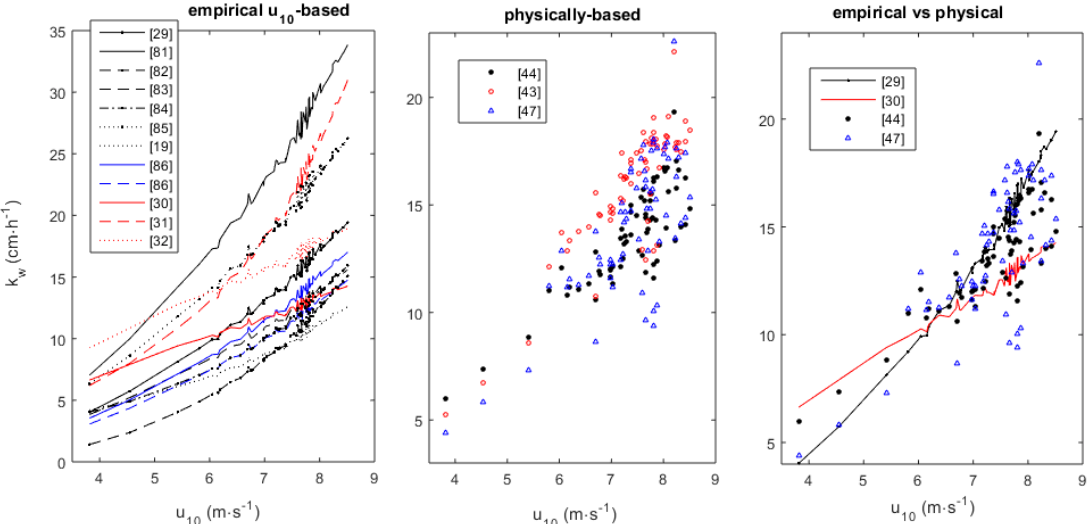
Figure 5. Comparison among transfer velocities (k w ) estimated for the Baltic experiment from empirical u 10 -based parameterizations and from extended physically based formulations. Were tested the empirical u 10 -based parameterizations by Wanninkhof et al. [19], Wanninkhof [29], Carini et al. [30], Raymond and Cole [31], Borges et al. [32], Jacobs et al. [81], Wanninkhof and McGillis [82], Nightingale et al. [83], McGillis et al. [84], Weiss et al. [85], Ho et al. [86], Were tested the physically-based parameterizations by Zhao et al. [43], Woolf [44] and Zhao and Xie [47] conjugated with the iWLP algorithm specific of the FuGas.